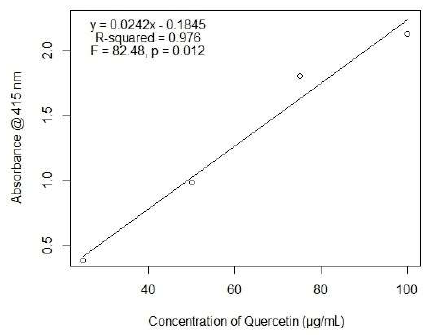
Figure 2. Calibration curve of quercetin obtained from the linear model.